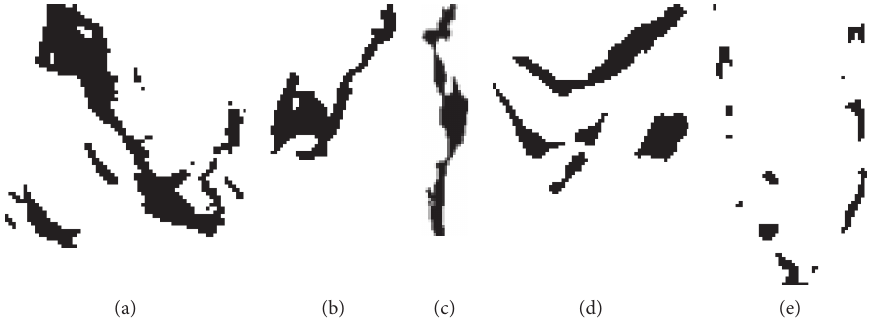
Figure 13: Crack characteristics: (a) 0.12m, (b) 1.56m, (c) 2.42m, (d) 6.12 m, and (e)